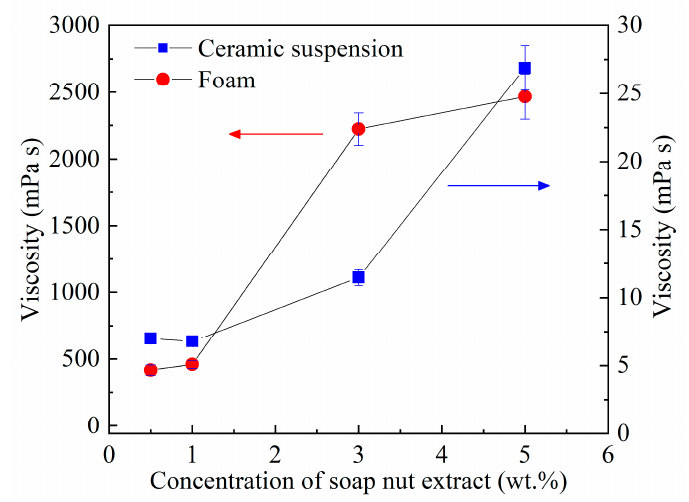
Figure 3. Viscosity of the ceramic suspensions and foams prepared with different content of SE at 25 °C, 37 vol.% MgAl 2 O 4 , and stirring at 1070 rpm for 2 min.